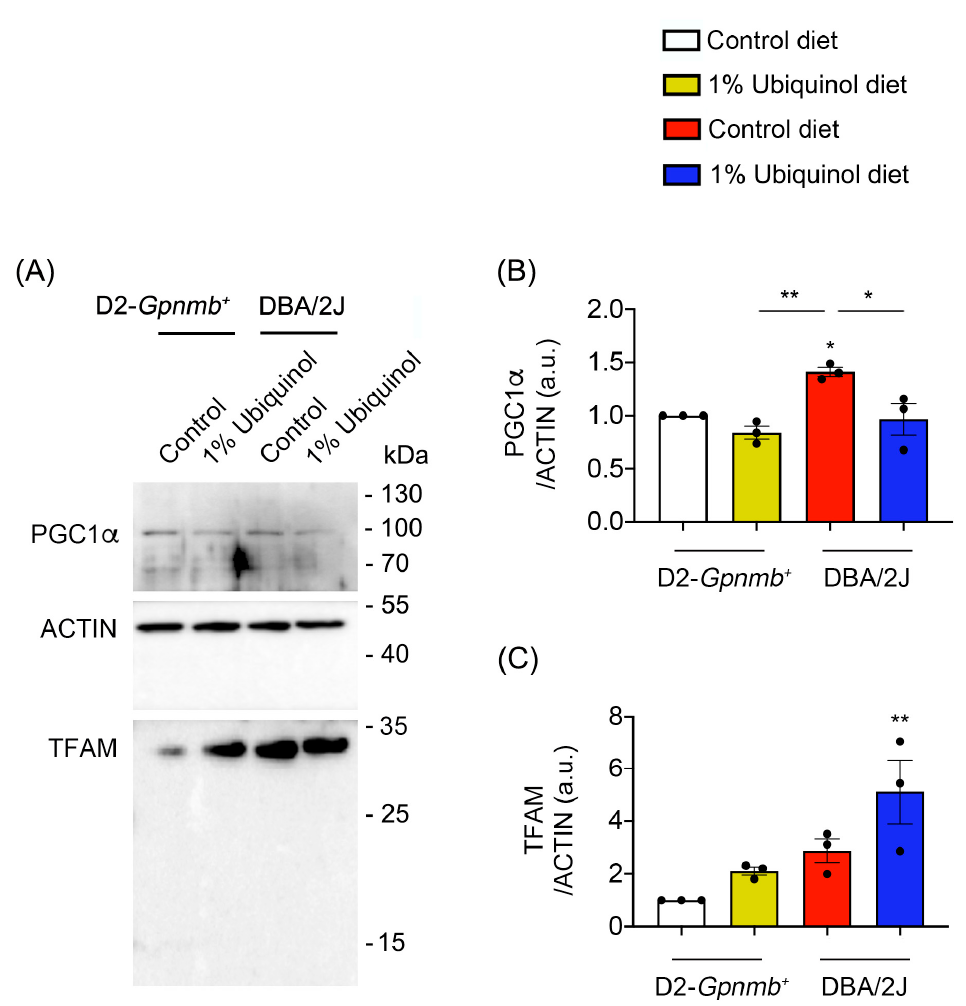
Figure 4. Effect of ubiquinol on PGC-1 α and transcription factor A ( TFAM) in the retina of glaucomatous DBA/2J mice. ( A – C ) Western blot analysis for PGC-1 α and TFAM protein expression in the retina. Data are expressed as mean ± SEM ( n = 4 retinas/mice/group). * p < 0.05 and ** p < 0.01 (One-way ANOVA with the Bonferroni post hoc test).